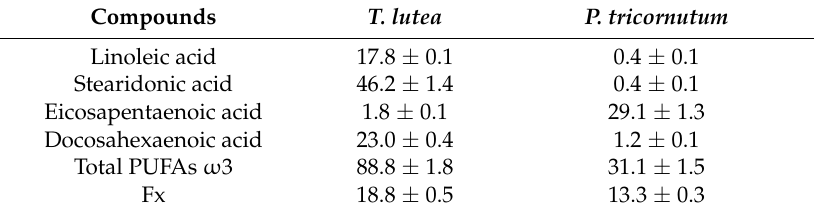
Table 1. Fucoxanthin (Fx) and long chain polyunsaturated fatty acids (PUFAs) contents 1 (mg · g − 1 DW) in Tisochrysis lutea and Phaeodactylum tricornutum from a batch of biomass harvested at the industrial scale, as means of three independent extractions and analyses for each